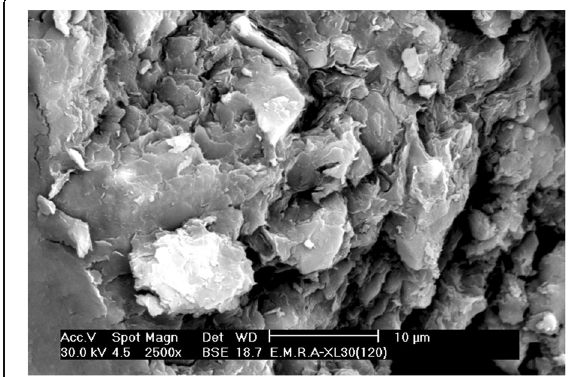
Fig. 6 SEM photomicrograph illustrating montmorillonite with relatively well-crystallized illite. Note that montomorillonite occurs as wavy